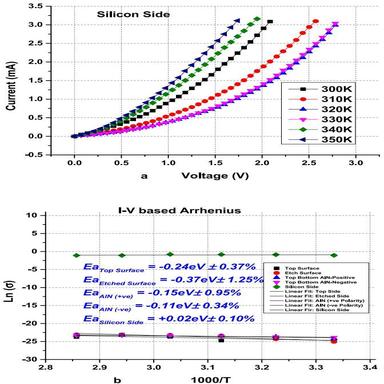
Temperature wise current-voltage analysis; (a) Silicon side Temperature wise IV analysis, (b) Arrhenius analysis of all said cases.